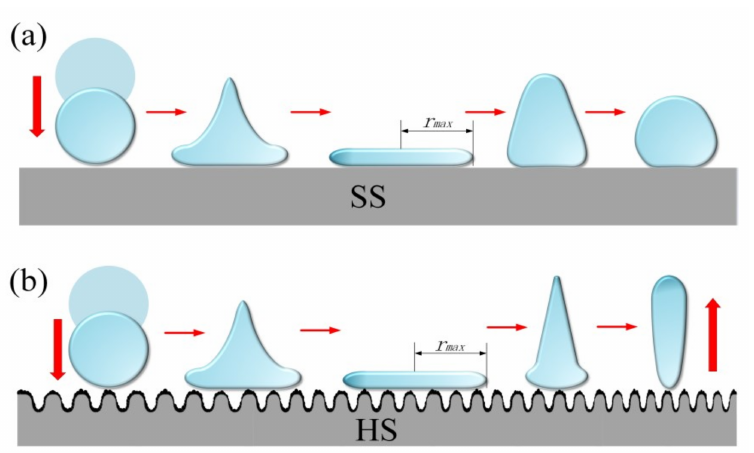
Figure 10. Droplet impact process. ( a ) Droplet impact process on SS; ( b ) droplet impact process on